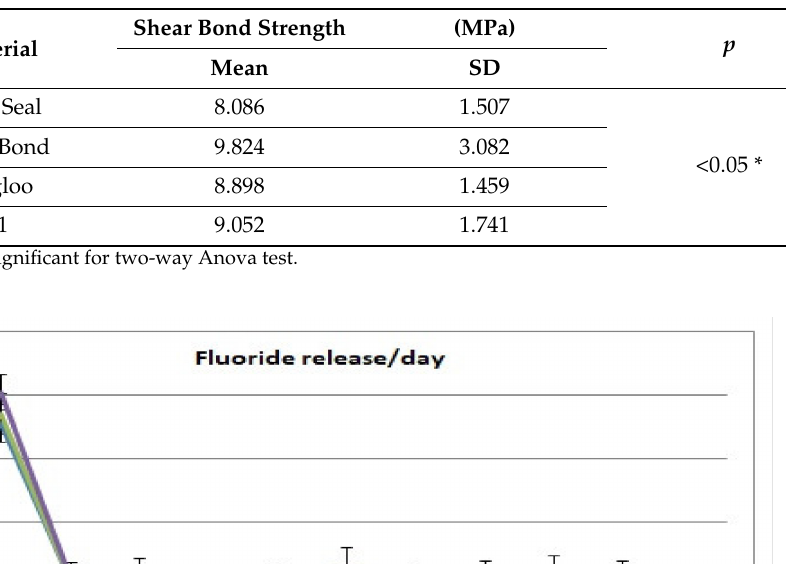
Table 2. Values of shear bond strength of the four materials.